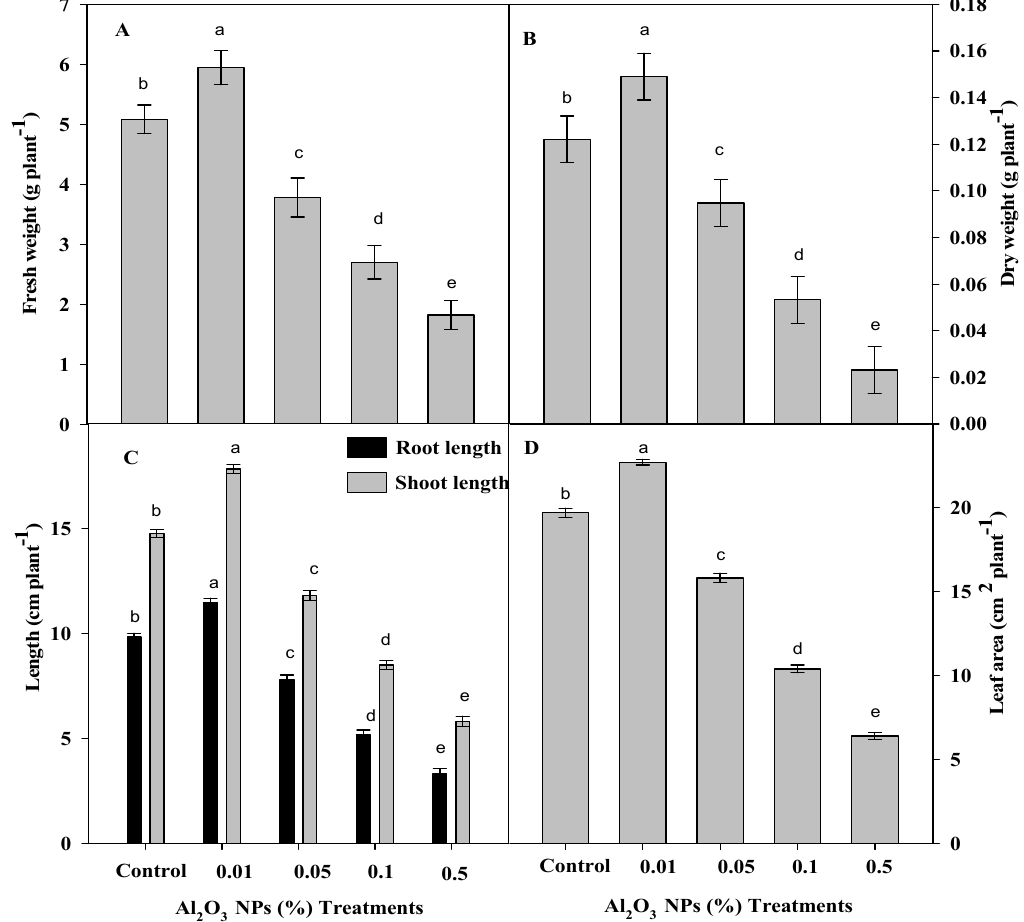
Figure 2. E ff ects of seed-priming with aluminum nanoparticles (Al 2 O 3 NPs) on ( A ) fresh weight, ( B ) dry weight, ( C ) root length and shoot length, and ( D ) leaf area in roselle plants. Bars represent standard deviation ( ± SD) of the means ( n = 3). Di ff erent letters indicate significant di ff erences among the treatments at p < 0.05, according to Duncan’s multiple range